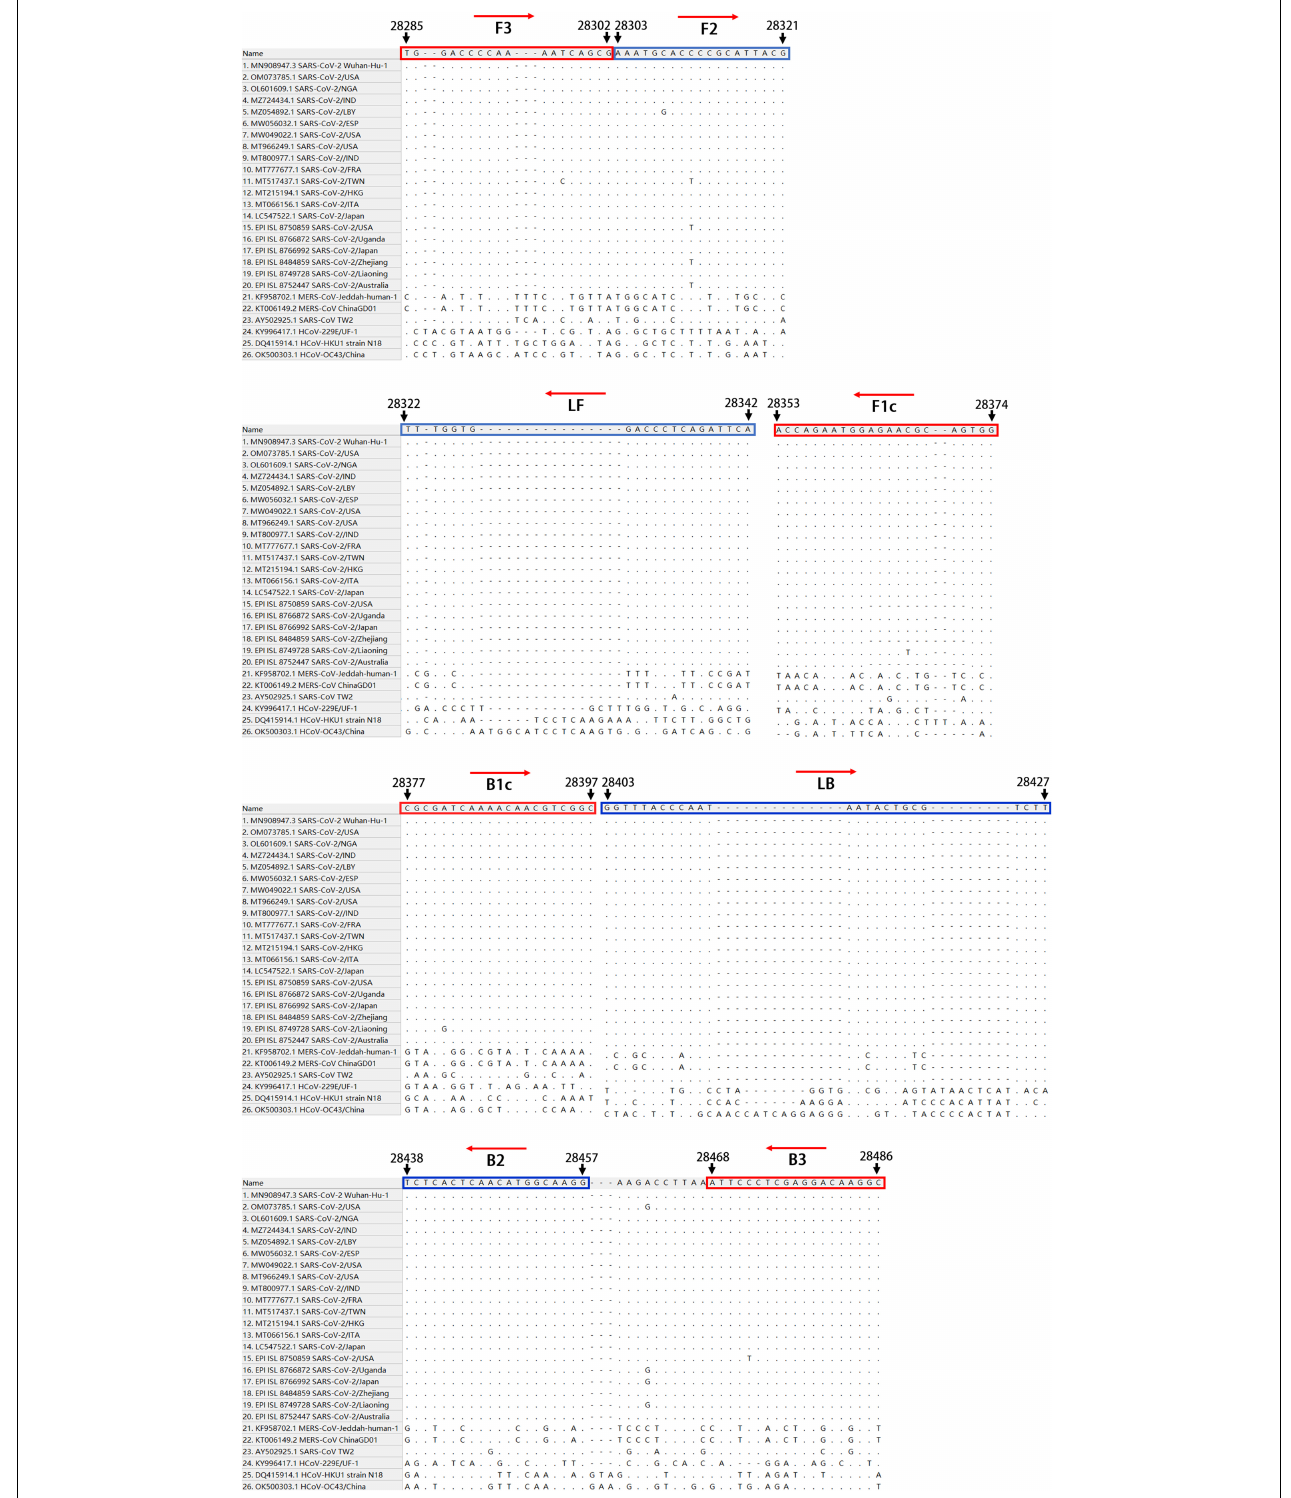
FIGURE 1 | The conserved and specific target were screened in SARS-CoV-2 N gene.